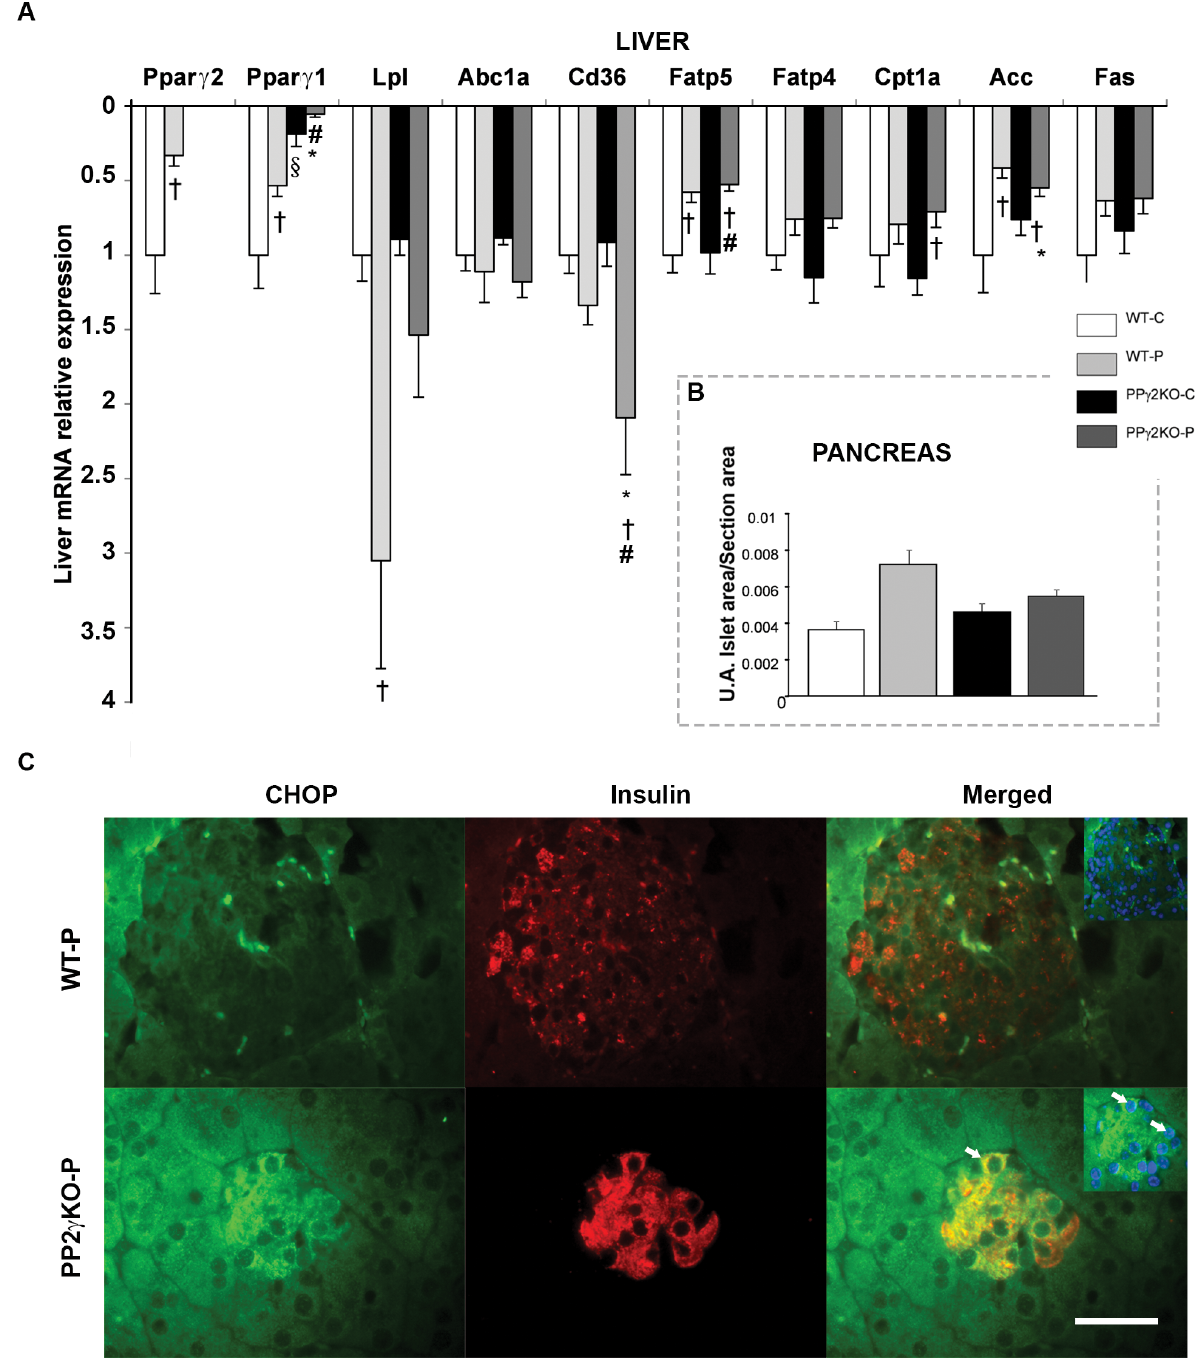
Figure 5. Expression levels of genes involved in hepatic lipid metabolism and morphological changes of the pancreas in the PP γ 2KO mouse at late pregnancy. (A) mRNA levels of hepatic lipid metabolism genes in pregnant and nonpregnant WT and PP γ 2KO mice (n = 6 animals/group). † p ≤ .05 pregnant versus non pregnant; # p ≤ .05 PP γ 2KO-P versus WT-C; § p ≤ .05 PP γ 2KO-C versus WT-C; * p ≤ .05 PP γ 2KO-P versus WT-P. (B) Average area of the islets relative to total area of the analyzed pancreatic section in each group (A.U.: arbi- trary units). (C) Representative images of insulin (red), CHOP (green) and nucleus (blue) immunohistochemistry in islets from pregnant WT and PP γ 2KO mice (n = 4 animals/group). Arrows indicate colocalization of insulin and CHOP. Merged show original magnification × 400. Scale bar: 50 μ